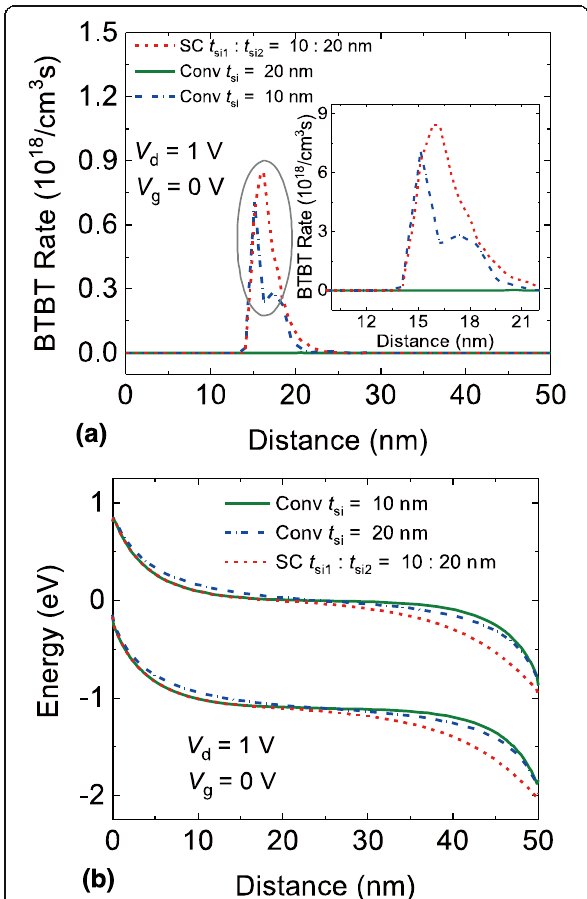
Fig. 3 a BTBT rates and b energy band diagram of the SC TFET and